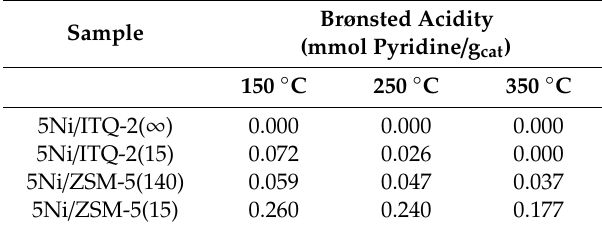
Table 2. Brønsted acidity of the 5 wt.% Ni catalysts supported on ITQ-2 and ZSM-5 with di ff erent Si / Al ratios.